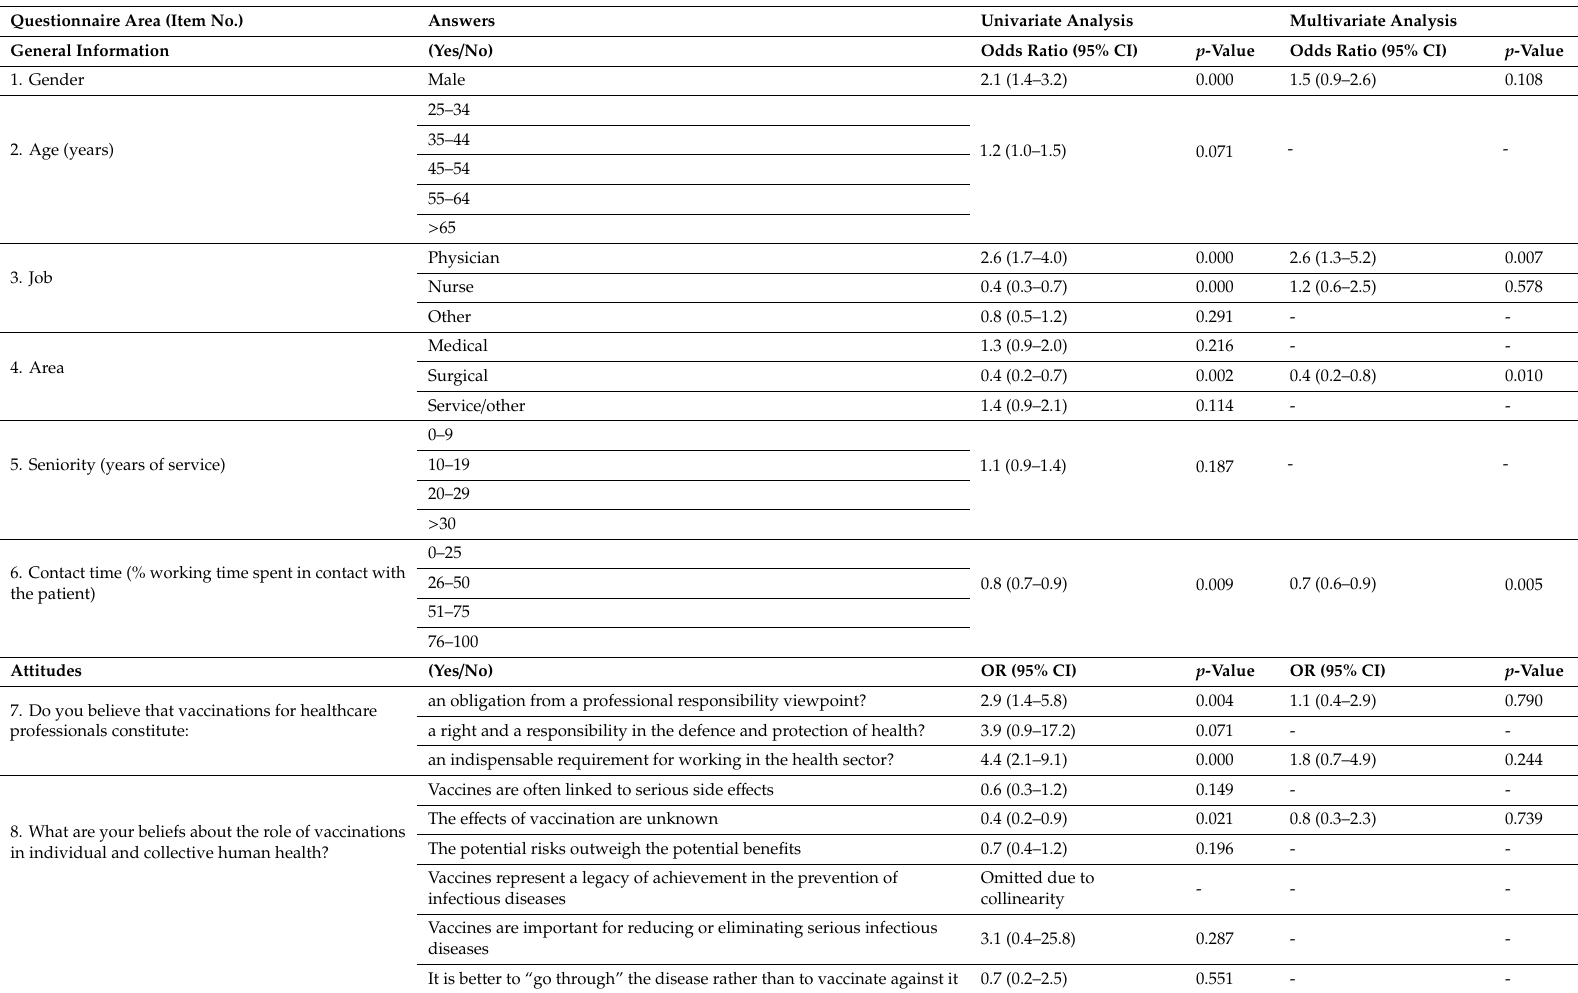
Table 3. Univariate and multivariate analysis evaluating the relationships between the independent variables and the outcome vaccinated / unvaccinated subjects in the 2018–2019